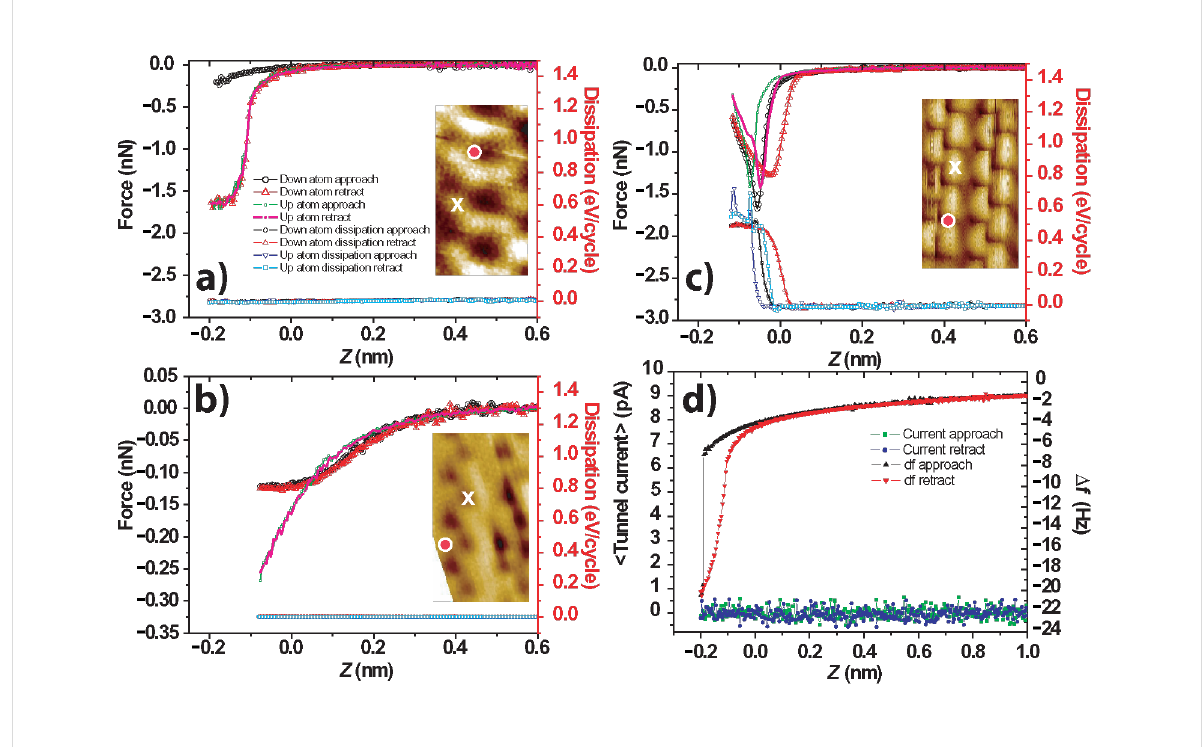
Figure 3: Experimental short-range force (nN) and dissipation (eV/cycle) as a function of relative tip–sample displacement for three different tip apices. The zero in the z scale indicates the feedback position. In each case spectroscopy was performed over the apparent location of both an “up’ and “down” dimer atom. Results were obtained with the same probe in one experimental session. (a) Data acquired with a tip demonstrating “conven- tional” atomic resolution. Δ f set = − 4.3 Hz, A 0 = 0.25 nm (3 × 3 median smoothing applied to inset figure). (b) Data acquired with a tip demonstrating “inverted” atomic resolution. Δ f set = − 5.1 Hz, A 0 = 0.1 nm. (c) Data acquired with a tip demonstrating “dimer” atomic resolution. Δ f set = − 8.4 Hz, A 0 = 0.25 nm. (d) Raw Δ f and I t data corresponding to the spectra in (a). We note that the tunnel current remains zero throughout, as was the case for the spectra in (b) and (c) (data not shown). Note that for (a) and (b) the dissipation signals for each of the spectra overlap within the noise of the data. Insets: Typical imaging for each tip type. Red dot: Location of spectra over “down” atom, White cross: Location of spectra over “up” atom. Keys are the same for each